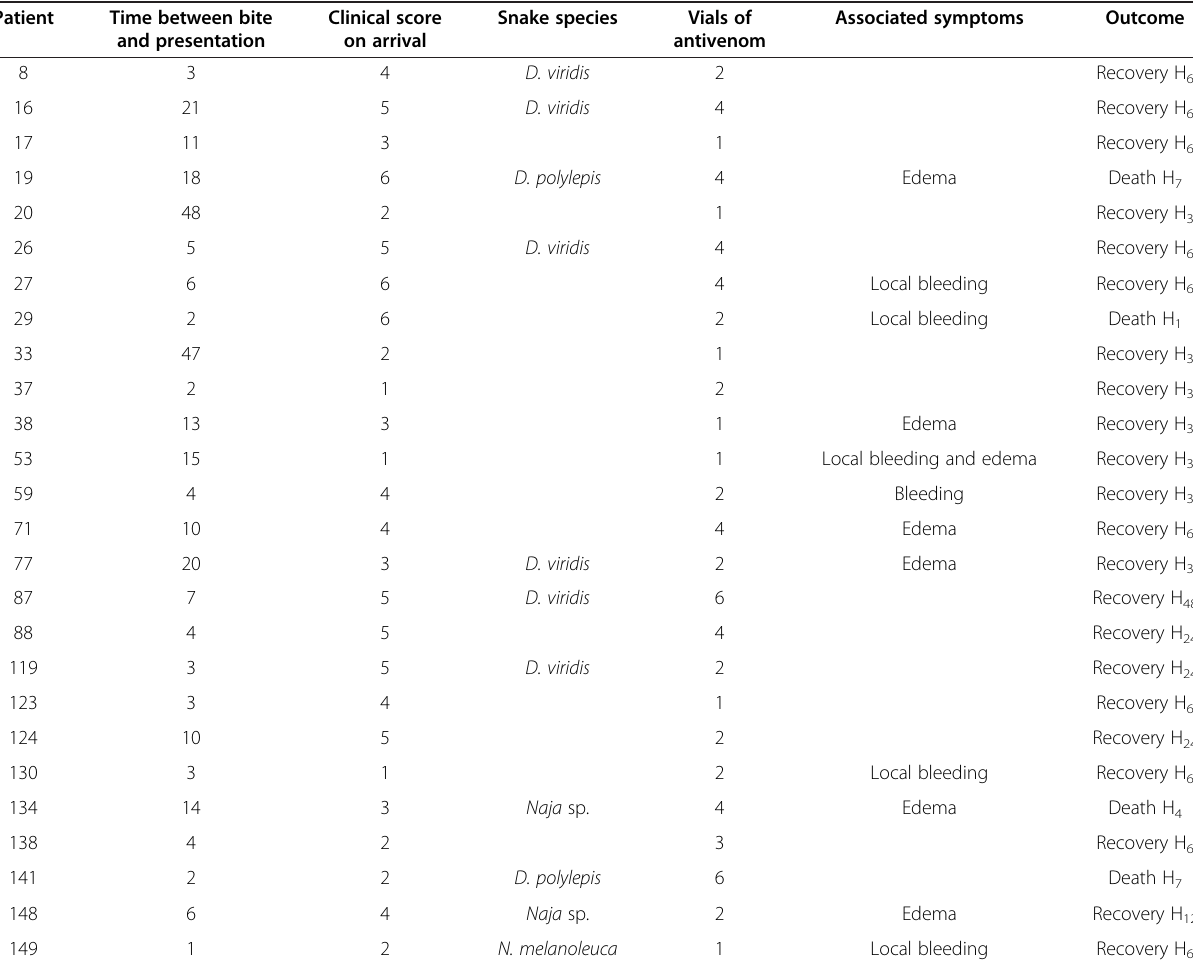
Table 3 Symptoms and time to death in patients of group 2 (low dose of antivenom)